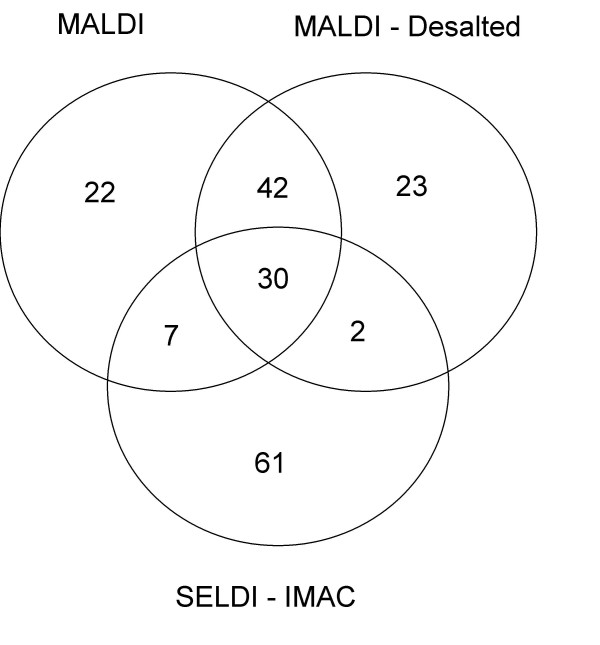
Overlap between SELDI and MALDI datasets. This Venn diagram shows the number of peaks detected in urine between m/z 1500 and 20,000 by MALDI, MALDI-DS and SELDI and the overlap between the 3 methods.